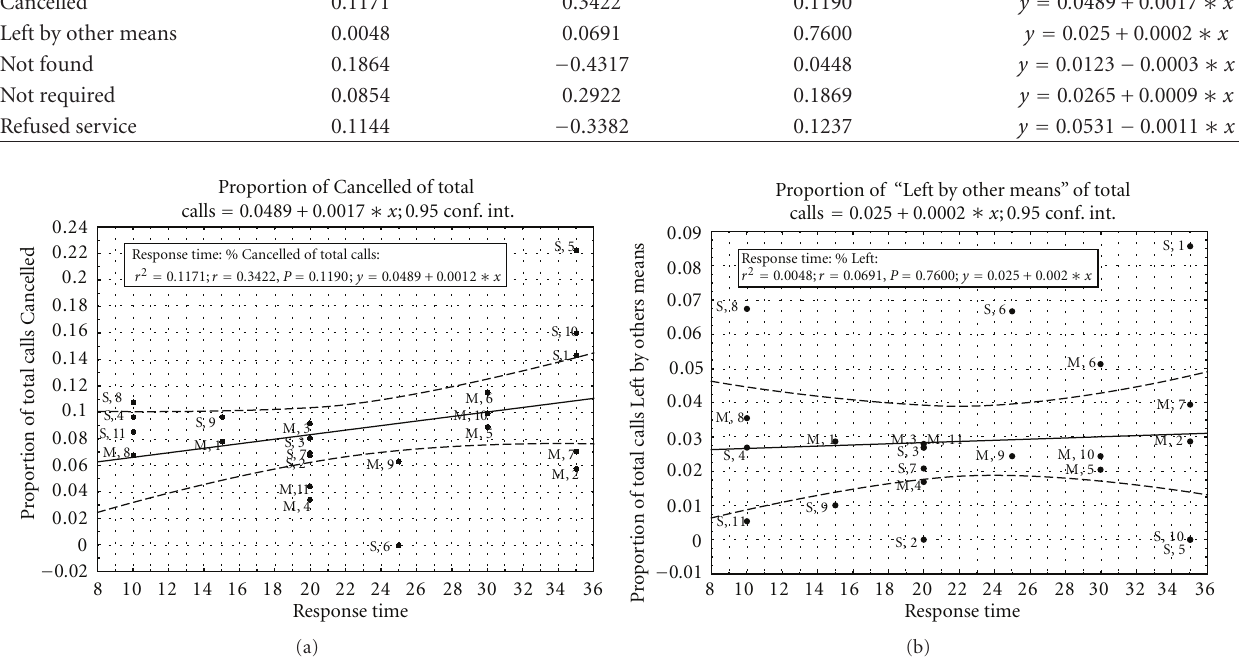
Figure 2: Correlation between response time and the call types Cancelled and Left by other means. Call types and average response time from the Barbados Ambulance Service from January to September